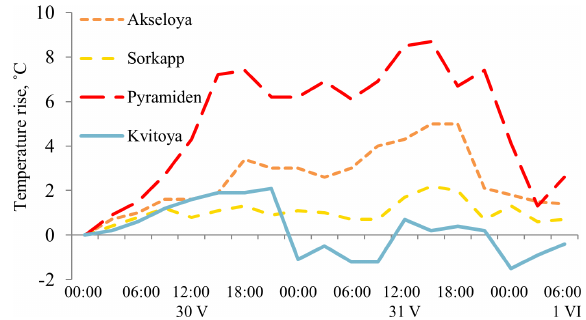
Figure 4. Temperature change from “initial” time at each individ- ual AWS station during foehn episode, where the initial time is 00:00UTC, 30